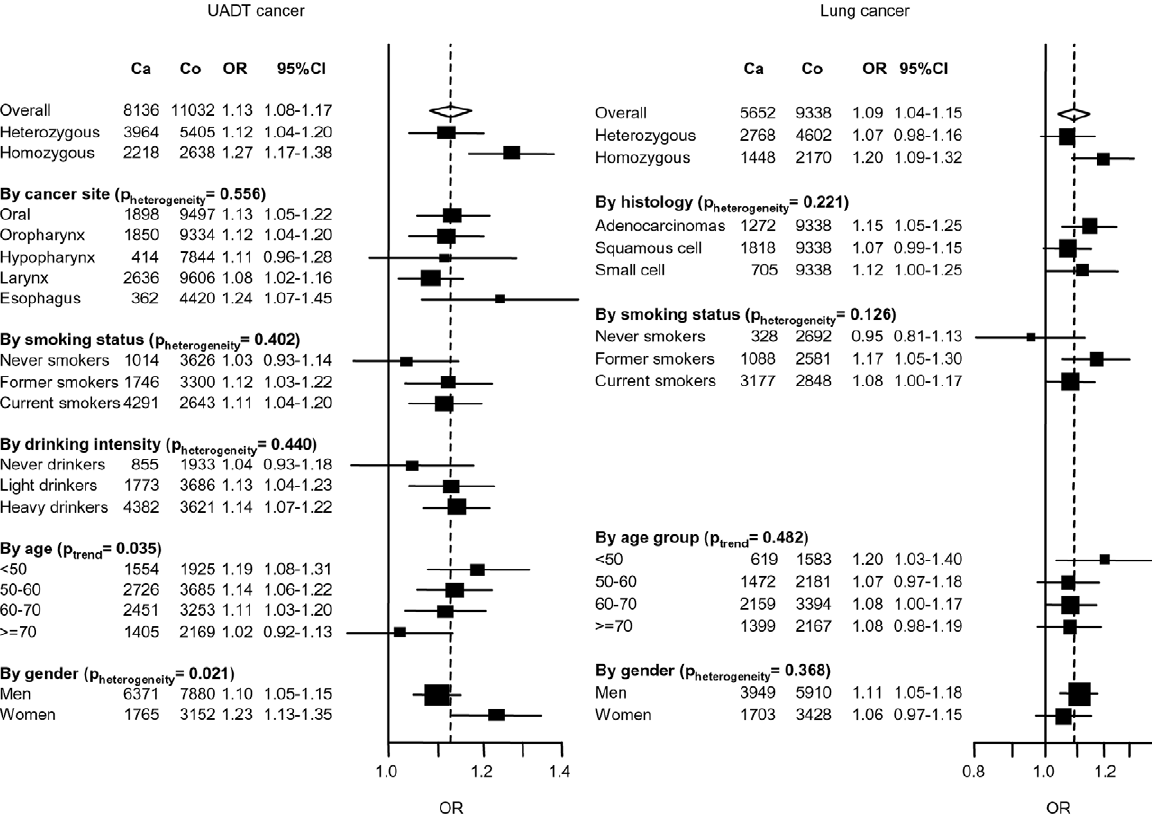
Figure 4. Association between 4q21 variant (rs1494961) and UADT and lung cancers. Estimates were derived from a log-additive model. ORs were adjusted by age, sex, study and were derived from fixed effects models. ‘‘Generic’’ controls were not included in this